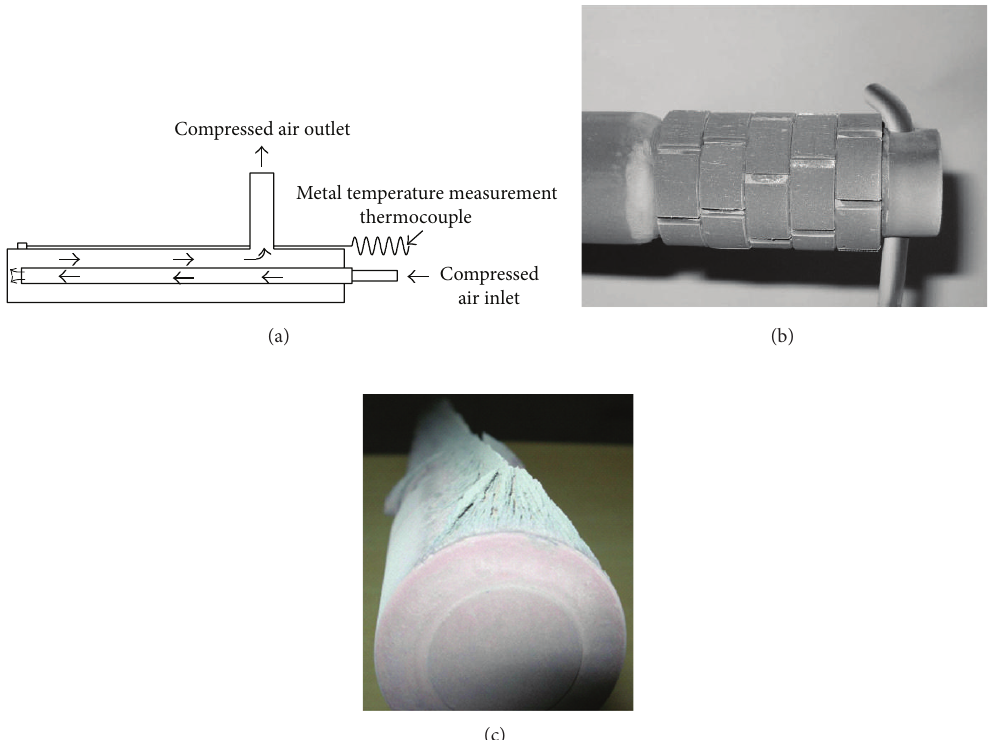
Figure 2: (a) Schematic sketch of probe to collect fouling samples, (b) steel probe with rings [2], and (c) foul probe with